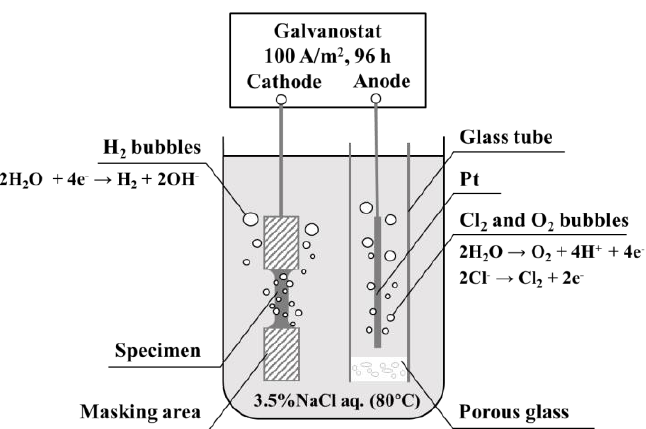
Figure 2. Schematic diagram of modified hydrogen charging.